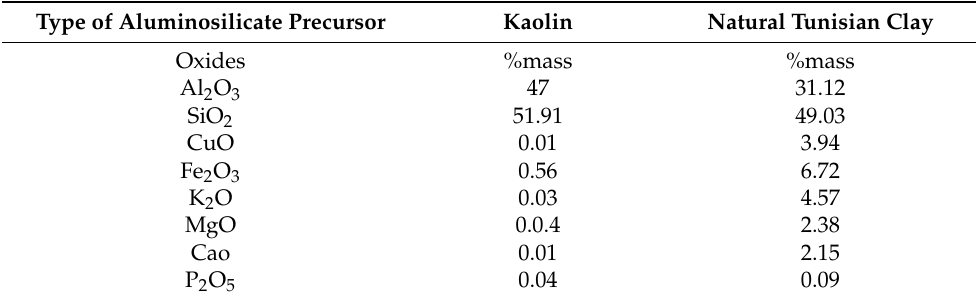
Table 1. Chemical composition of the used aluminosilicate precursors.